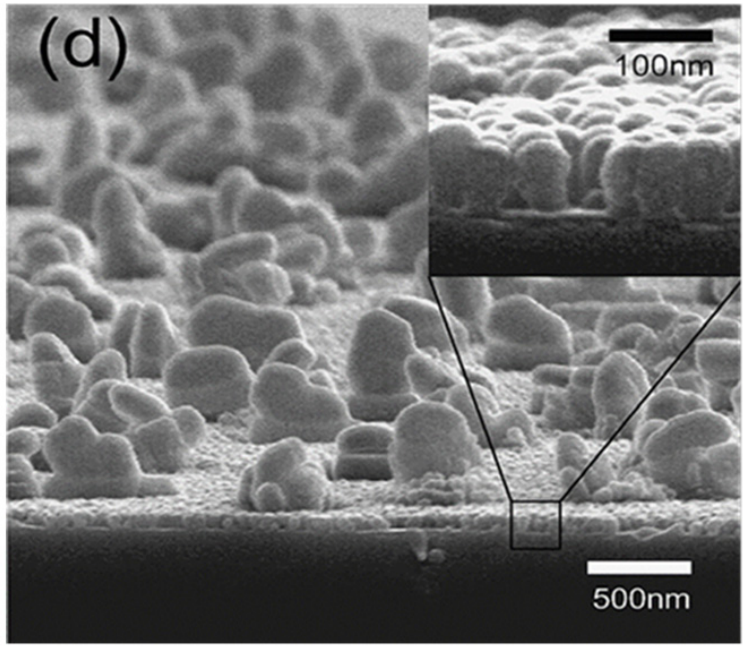
Figure 18. SEM image of Si wafer surface etched at 150 W r.f. power using CF 5 Pa with the Cu nanodots. Images reprinted from [122], with permission from Elsevier, Copyright